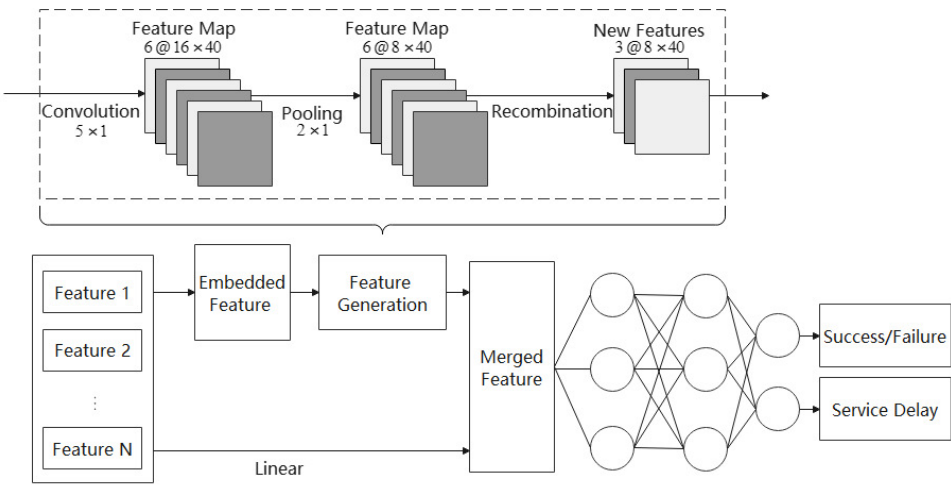
Figure 2. Prediction model with automatic feature